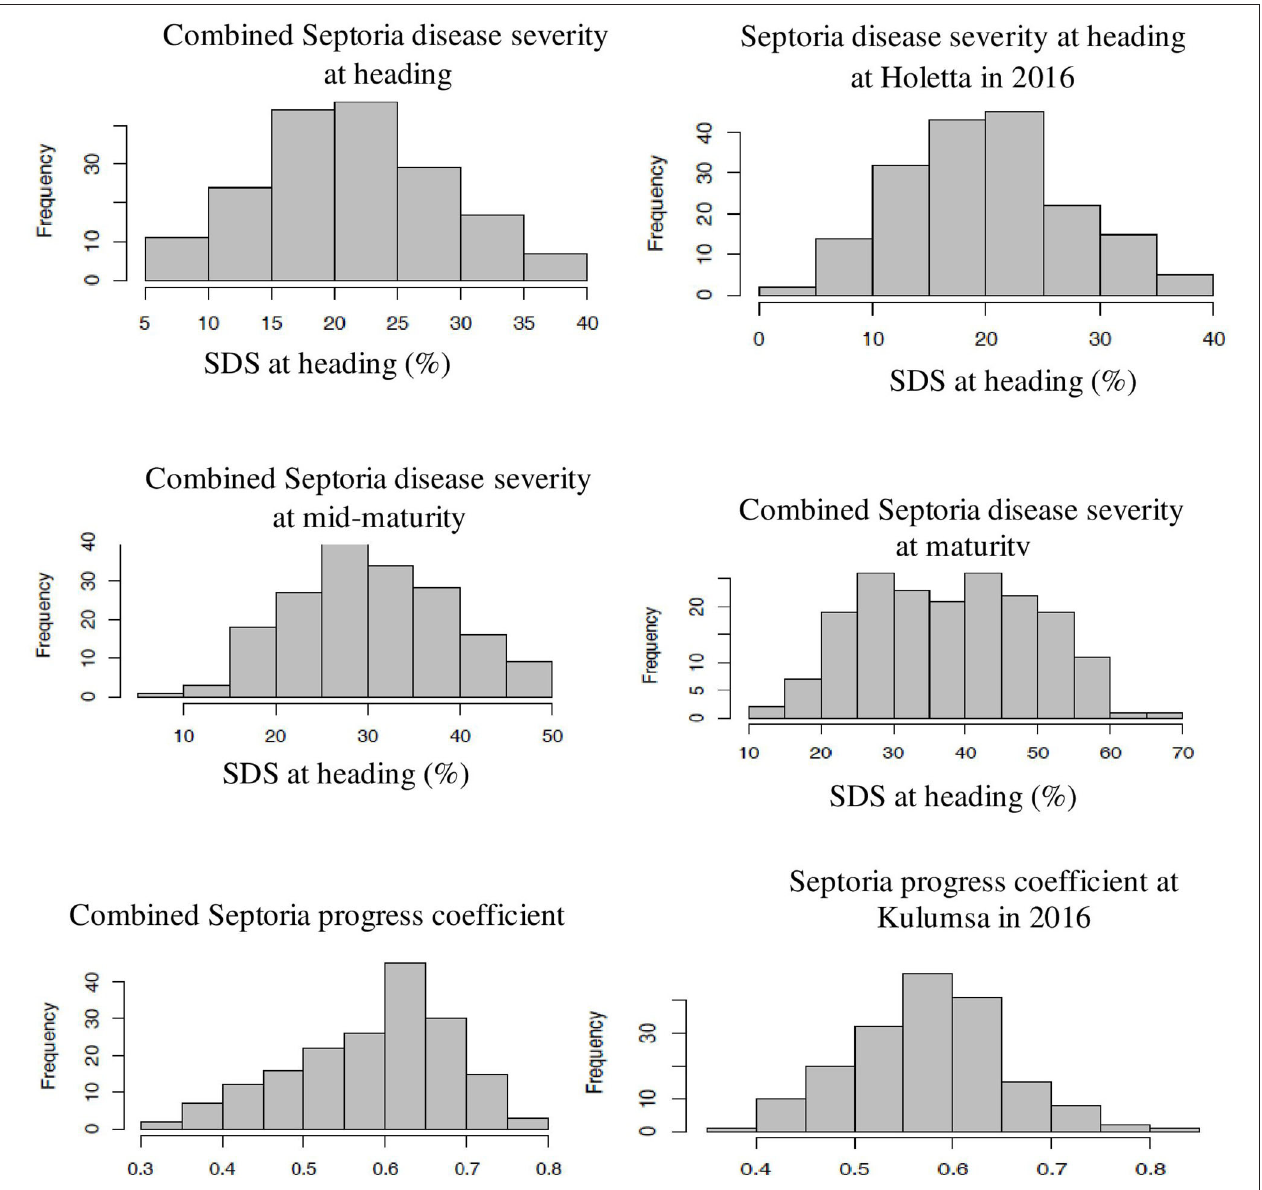
FIGURE 1 | Frequency distribution of some SDS traits. The combined data were from three locations and over 2 years field evaluation of 180 wheat genotypes. The right and left ends of the graphs indicate the highest and lowest affection classes, respectively. The combined Septoria disease severity at heading, mid-maturity, and maturity stages followed a normal distribution. The severity values increased from heading to mid-maturity, and then to maturity stages. Combined Septoria progress coefficient showed pseudo-normal distribution, confirming the quantitative nature of STB resistance in the tested wheat material. The x-axis represents the BLUE value of the study